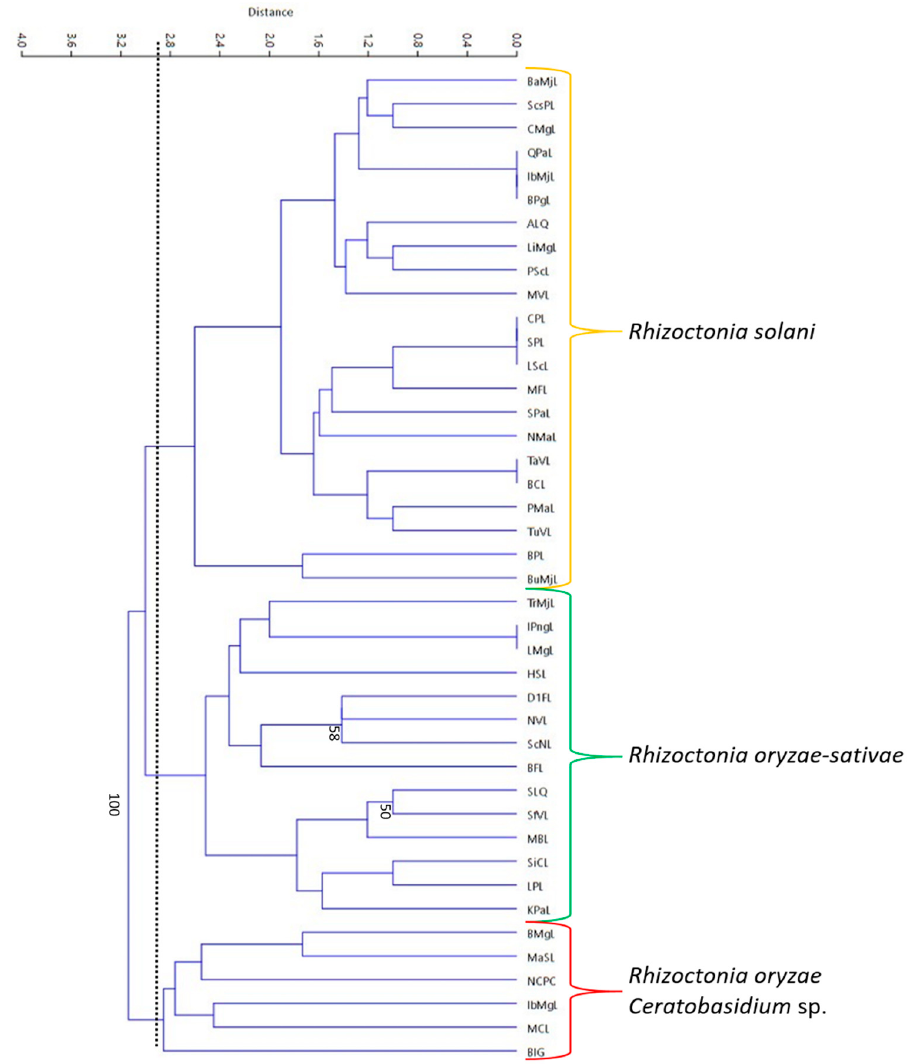
Figure 9. The repetitive-element PCR (Rep-PCR) generated dendrogram for the 42 Rhizoctonia isolates. A 2.9 similarity index (as measured by distance) was used for the interpretation of relatedness as depicted by the vertical line. Isolates clustered into three groups: R. solani , R. oryzae-sativae , and R. oryzae and Ceratobasidium sp. Bootstrap values below 50 were no longer included in the dendrogram.